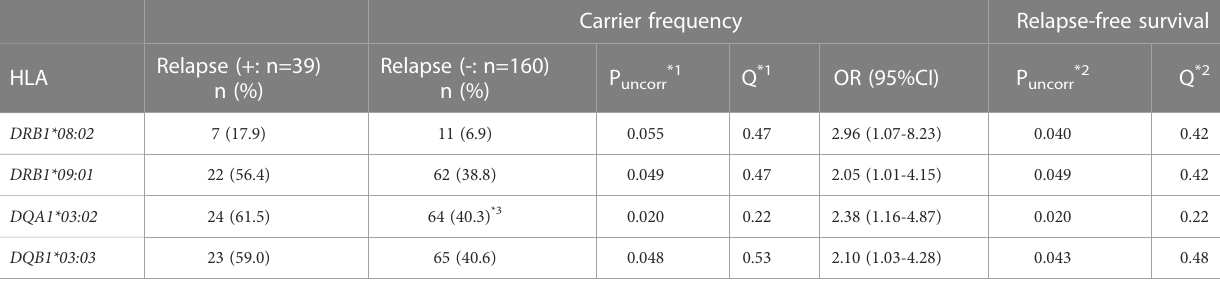
TABLE 4 Association of HLA class II alleles with occurrence of relapse and risk of relapse. Carrier frequency Relapse-free survival